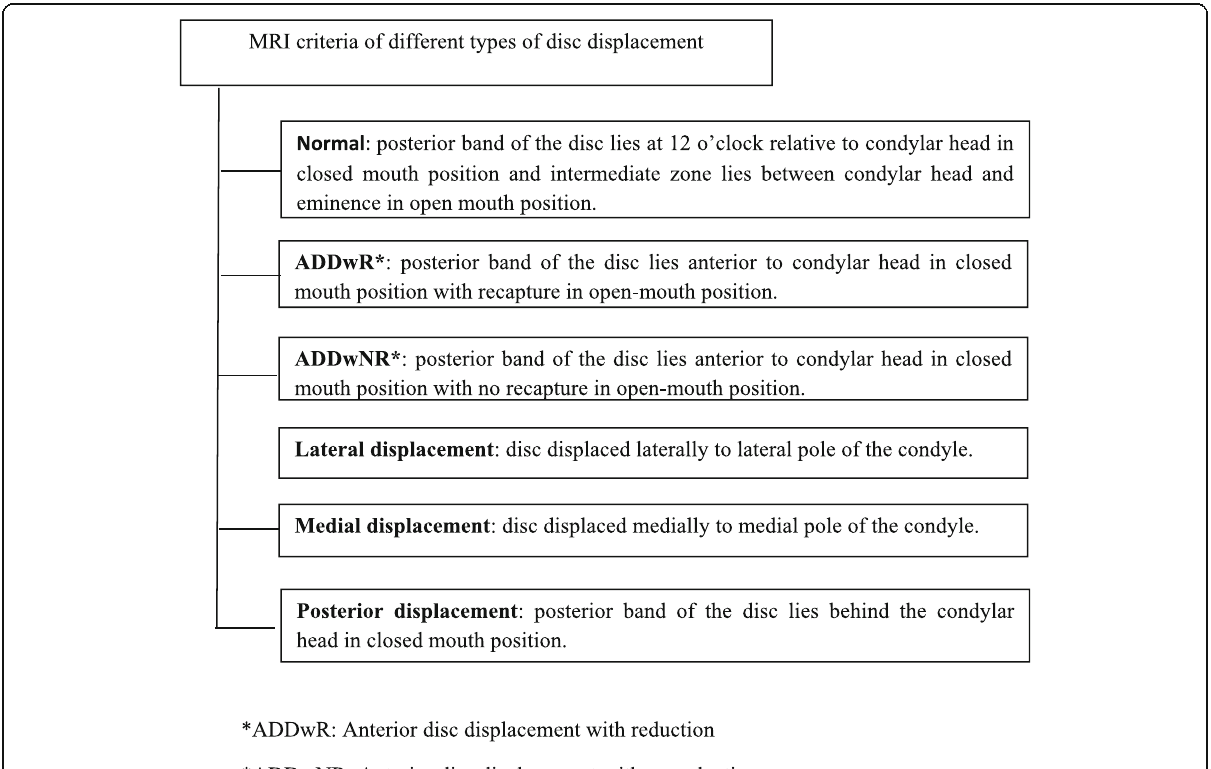
Fig. 1 MRI criteria of different types of TMJ disc displacement. *ADDwR, anterior disc displacement with reduction. *ADDwNR, anterior disc displacement with no